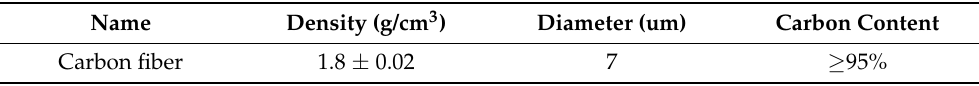
Table 2. Specifications of the carbon